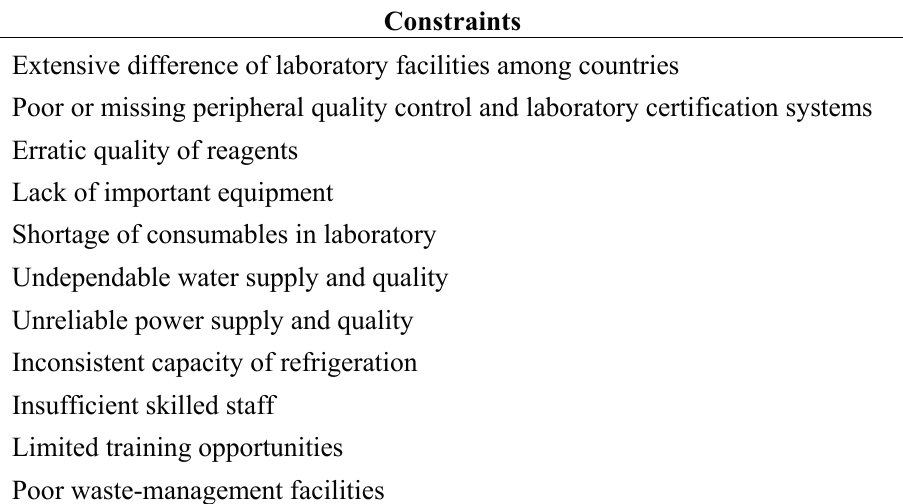
Figure 8. An illustration of a cell membrane in the nano-meter scale [243]. Table 12. Laboratory structure constraints and